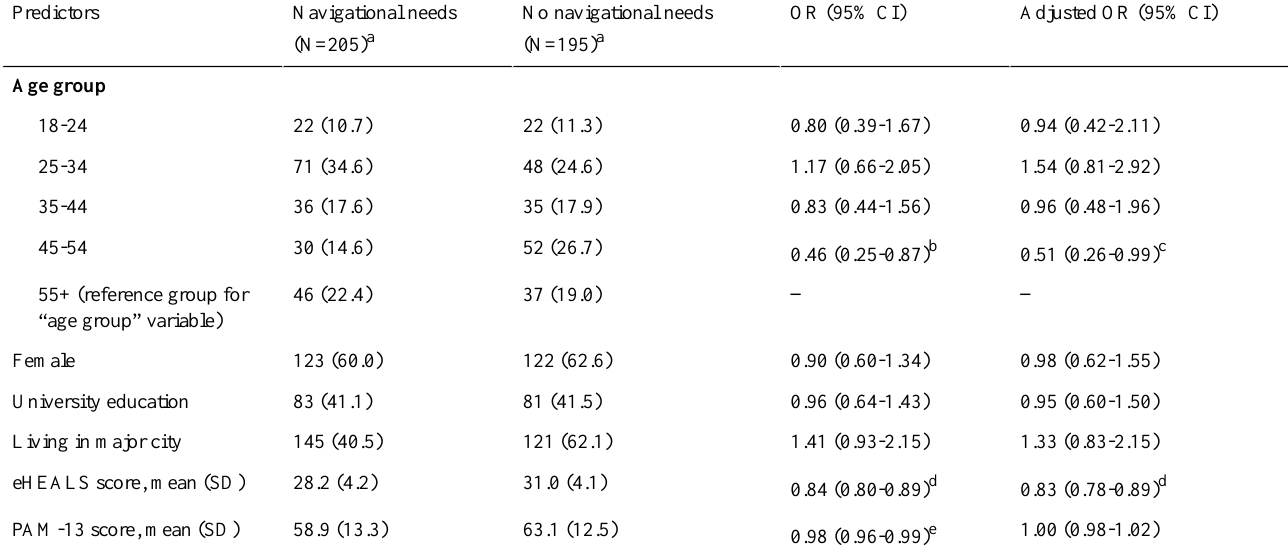
Table 9. Predictors of navigational